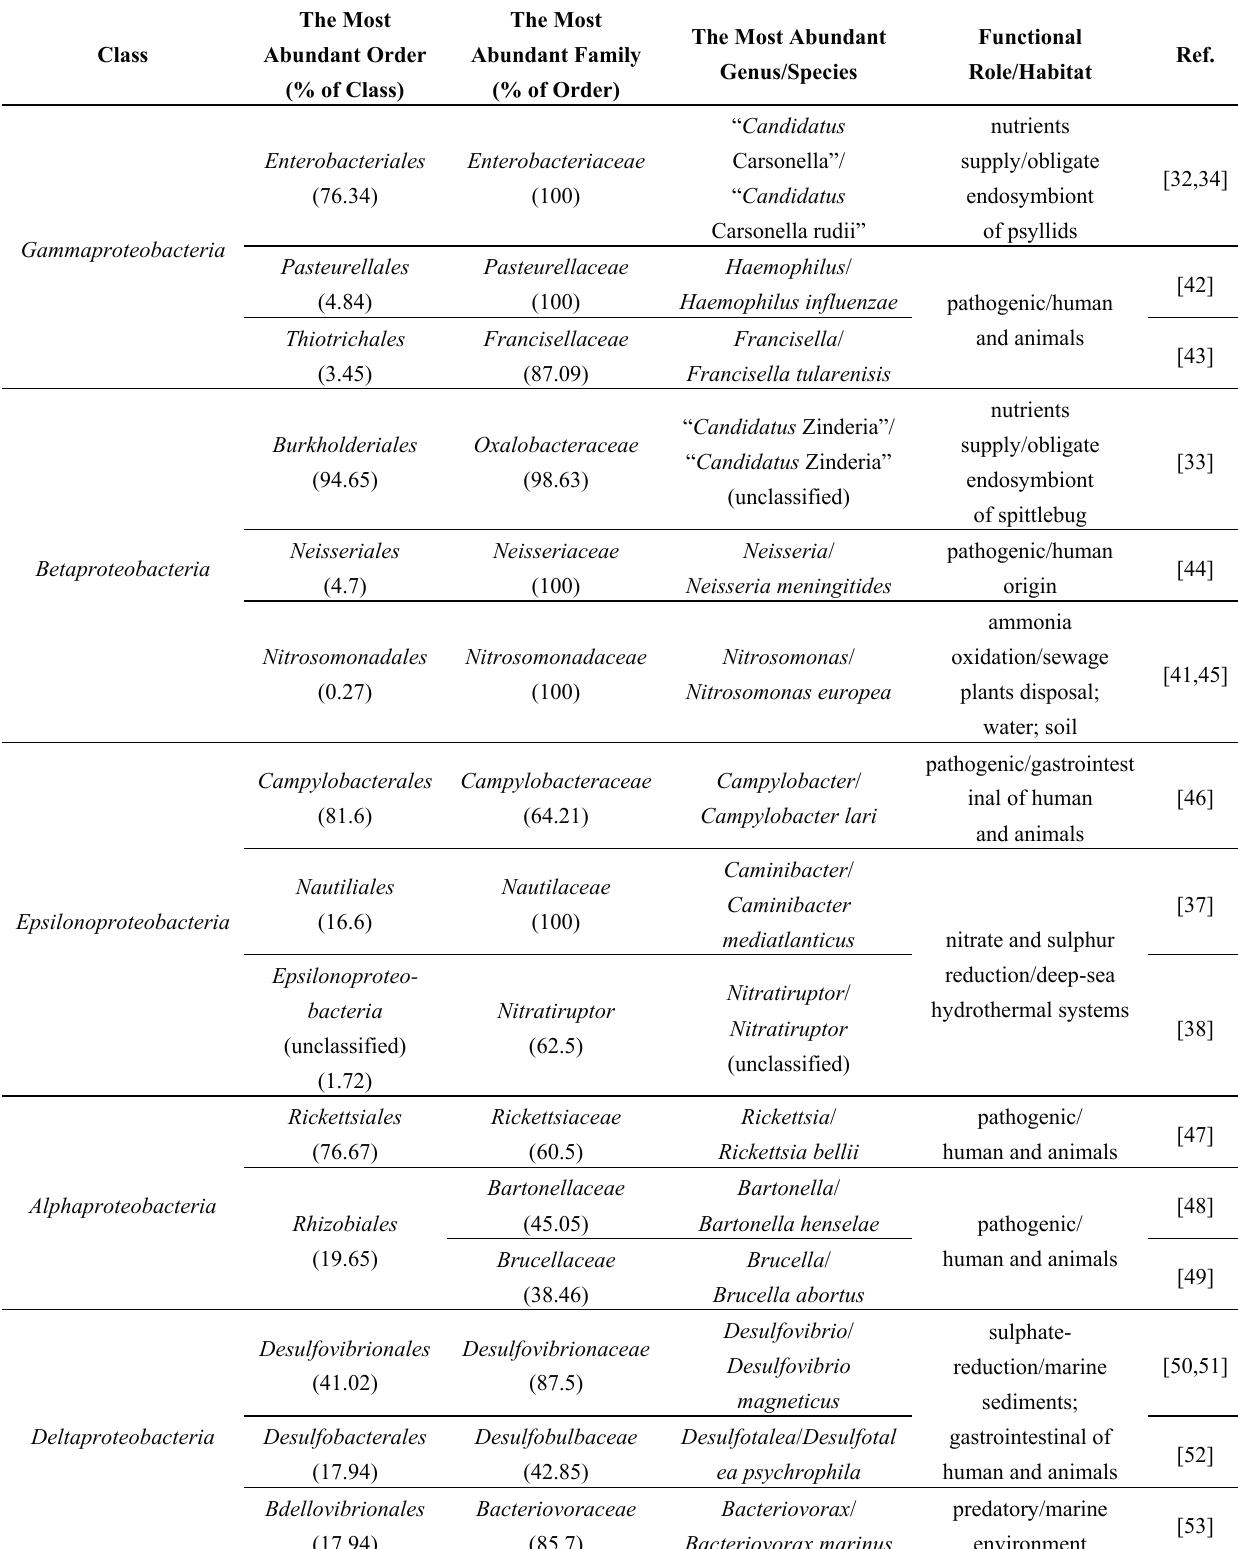
Table 1. Categorization and predicted function of members of the phylum Proteobacteria .